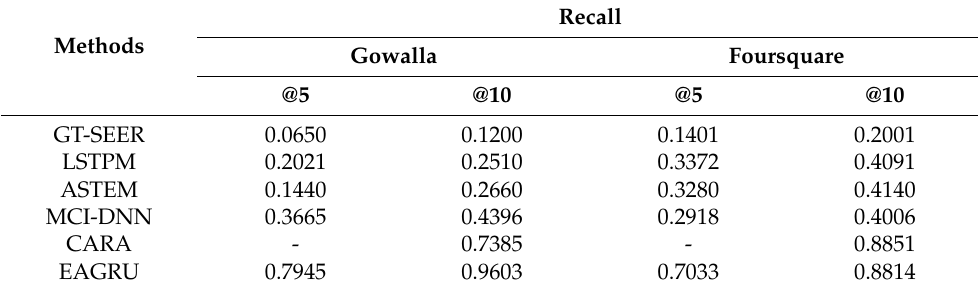
Table 6. A comparison between different methods for recommendation